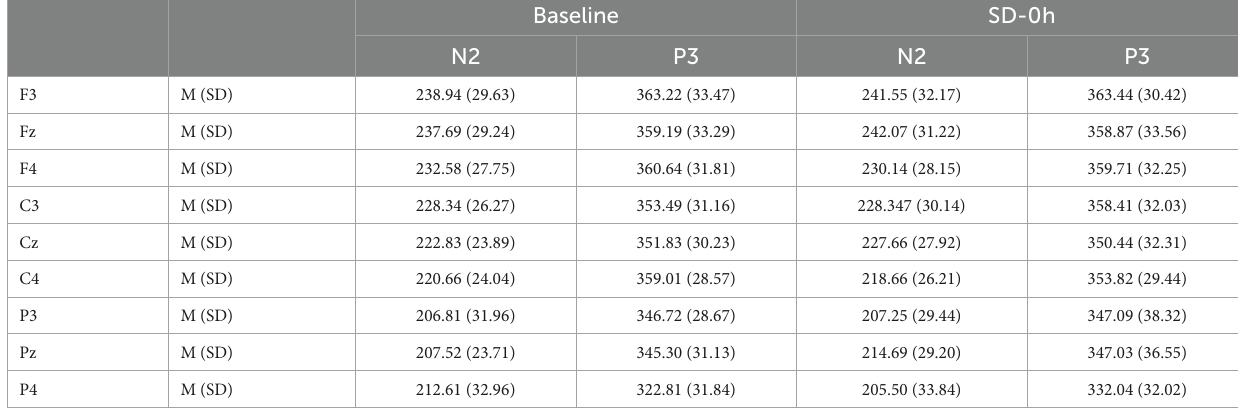
TABLE 3 Grand-average peak latency of the N2 and P3 components for correct responses across multiple electrode sites at baseline and after 0 h of sleep deprivation (SD0) in the nocturnal sleep (NS)